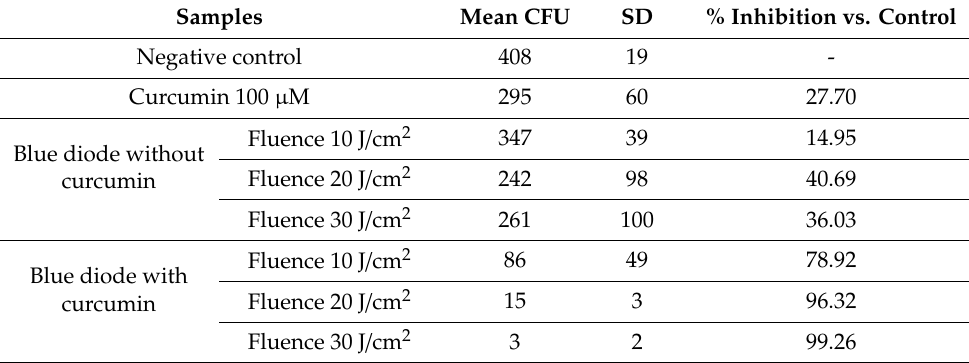
Table 3. E ff ect of green laser (532 nm) application on bacterial suspensions with and without erythrosine. Samples Mean CFU SD % Inhibition vs. Control Negative control 572 Erythrosine 100 µ M Fluence 10 J / cm 2 Green diode without erythrosine